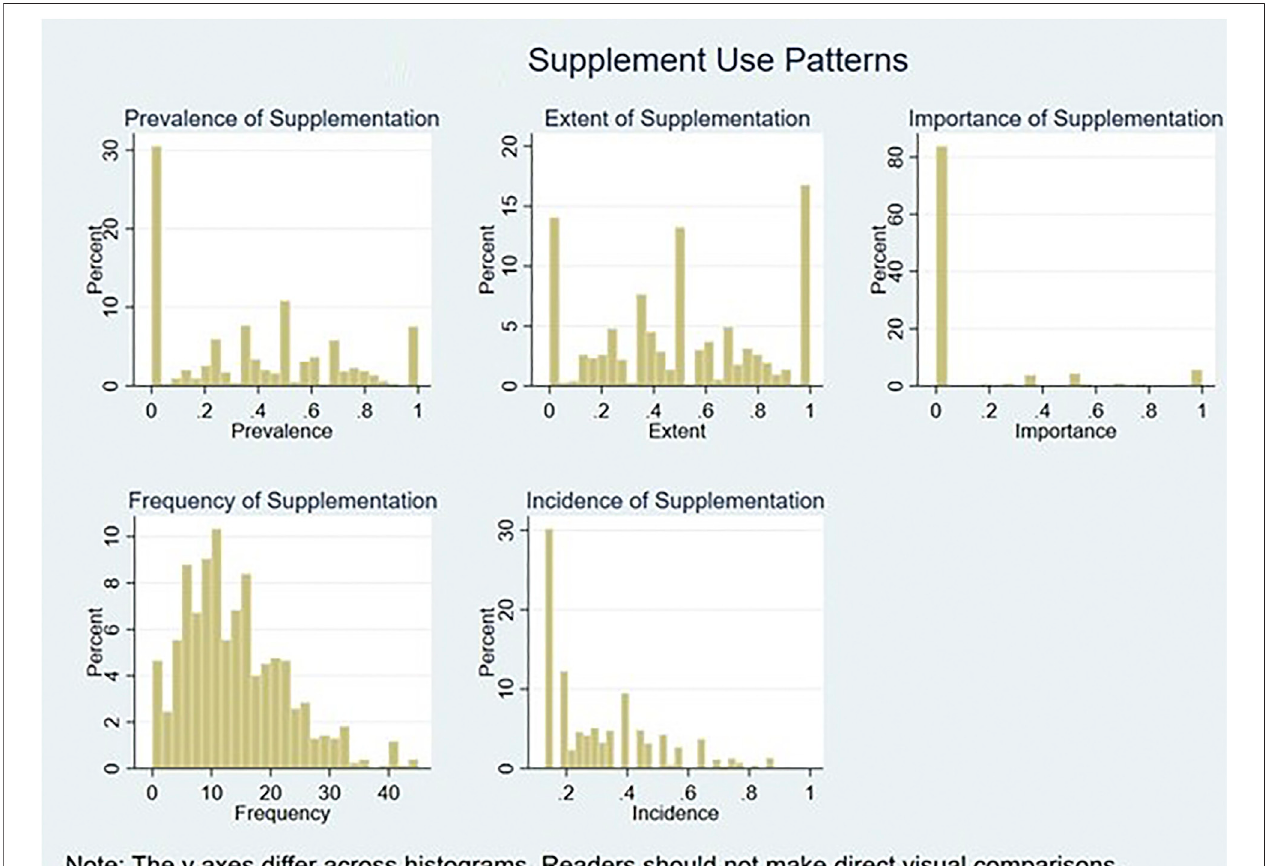
FIGURE 2 | Histograms of teacher supplement use patterns.